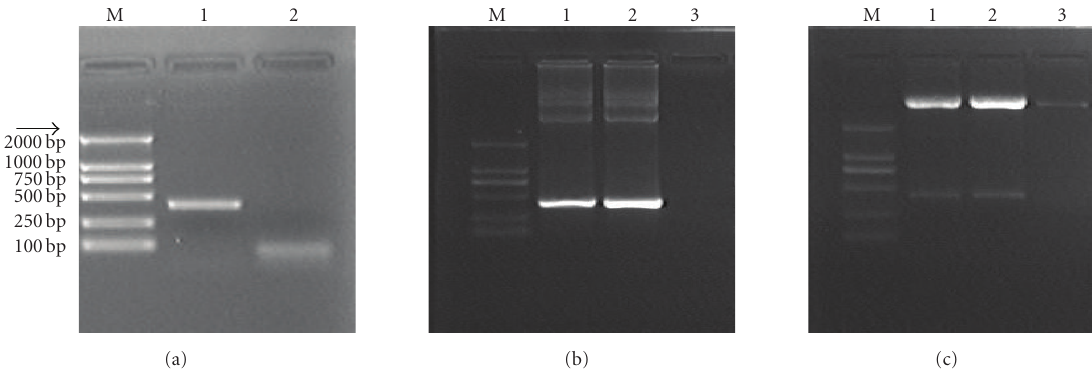
Figure 3: Identification of the recombinant plasmid pIRES2-EGFP-HBs. (a) PCR result of HBs gene before transformation. M: Markers; 1: HBs gene; 2: negative control. (b) PCR result of HBs gene after transformation. M: Markers; 1 and 2: HBs gene; 3: negative control after transformation. (c) Result of enzyme digestion. M: Markers; 1 and 2: pRIS2-EGFP-HBs digested using EcoiR I and Sal I after transformation; 3: pRIS2-EGFP empty as native control.